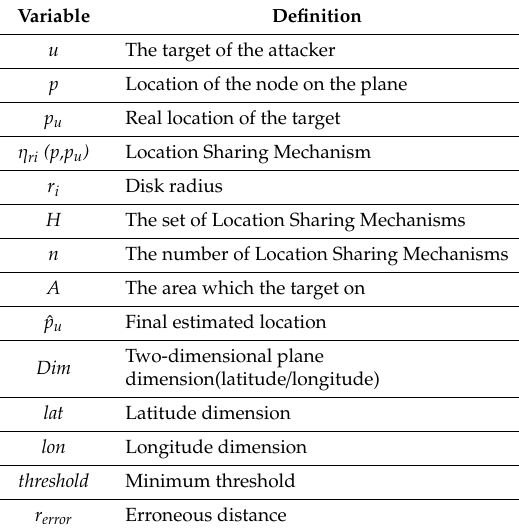
Table 1. The variables in ESPAA.